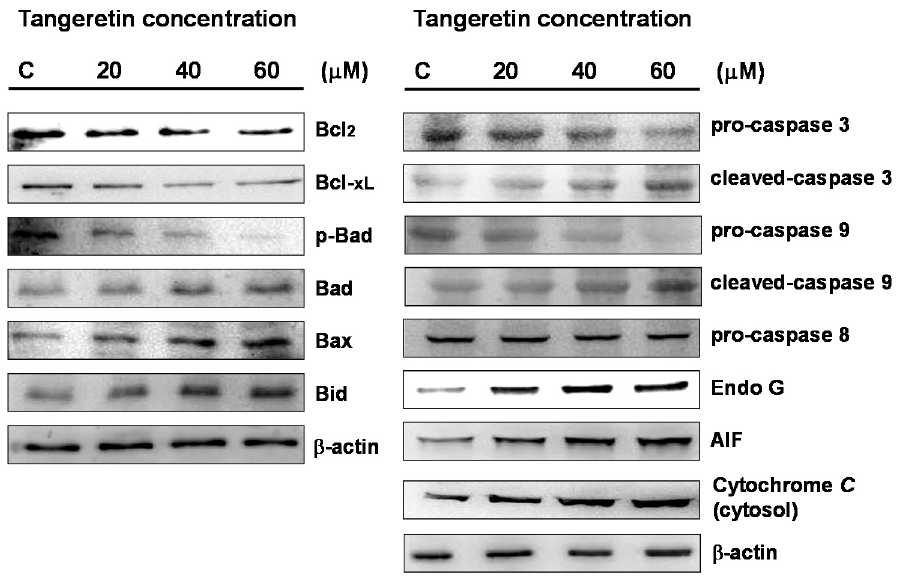
Figure 5. Changes in mitochondrial proteins, Bcl-2 family proteins, and caspases in BFTC-905 cells treated with different concentrations of tangeretin. AIF: apoptosis inducing factor.